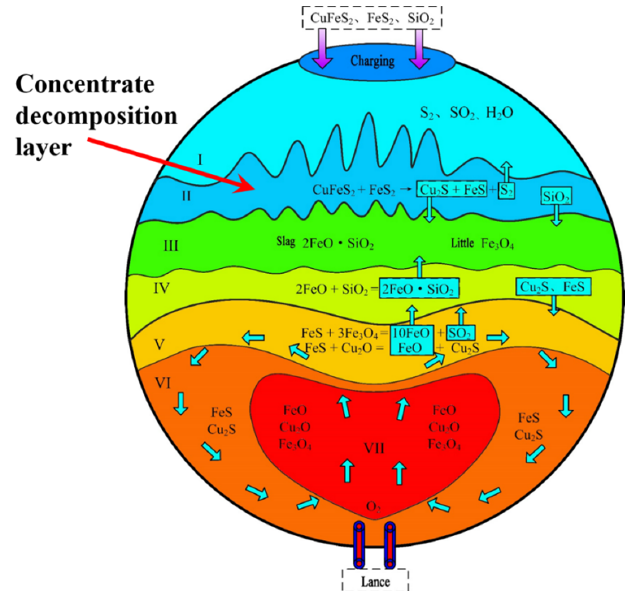
Figure 8. Mechanism model of SKS process in reaction